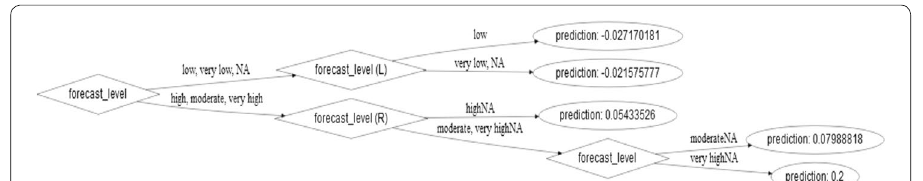
Fig. 13 GBM model’s forecast distribution for backorder class